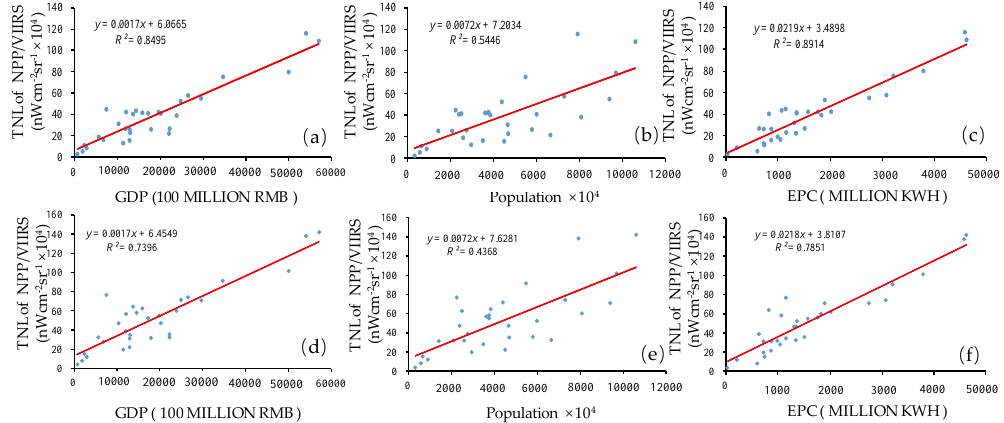
Figure 6. The scatter diagram of the linear regression analysis at provincial scale. Linear regression of (a) the corrected NPP-VIIRS data and GDP; (b) the corrected NPP-VIIRS data and population; (c) the corrected NPP-VIIRS data and EPC; (d) the original NPP-VIIRS data and GDP; (e) the original NPP-VIIRS data and population; (f) the original NPP-VIIRS data and EPC.